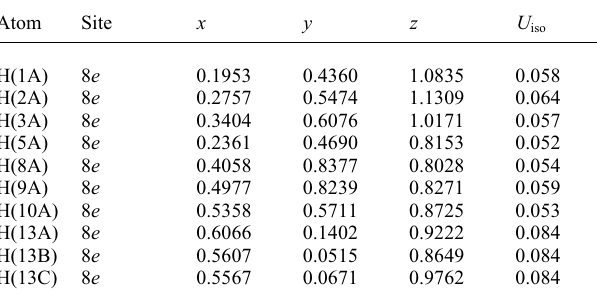
Table 2. Atomic coordinates and displacement parameters (in Å 2 )